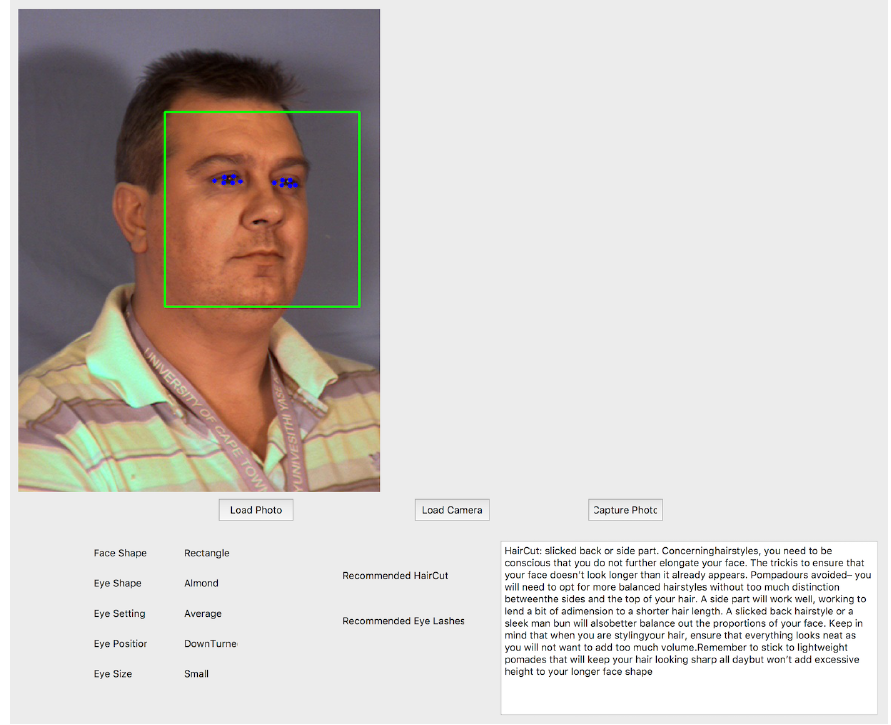
Figure 9. GUI of facial and eye attributes predication showing man